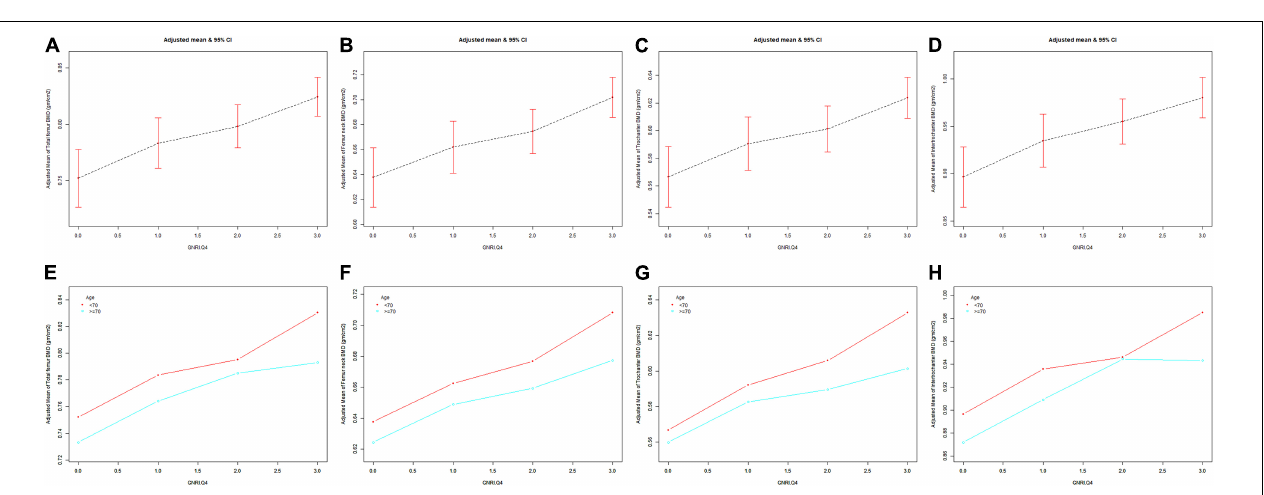
FIGURE 2 | The SCF for the association between GNRI and femur BMD. Age [in panels (A–D) ], race/ethnicity, BMI, educational level, marital status, PIR, smoked at least 100 cigarettes, hypertension status, diabetes status, ever used prednisone or cortisone daily, ever used female hormones, had a hysterectomy, moderate or vigorous activity, and postmenopausal period were adjusted. (A,E) Total femur BMD; (B,F) Femur neck BMD; (C,G) Trochanter BMD; (D,H) Intertrochanter BMD. SCF, smooth curve fit; BMD, bone mineral density; GNRI, geriatric nutritional risk index; PIR, poverty income ratio; BMI, body mass index.